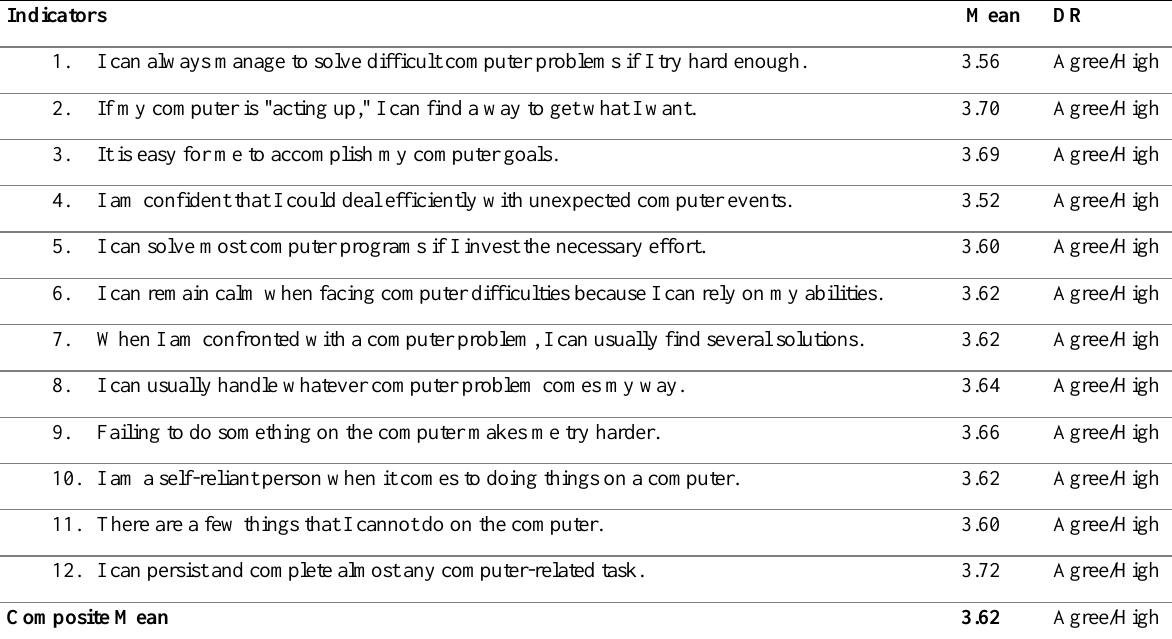
Table 1: Computer self-efficacy of the employees of Divine Word College of Laoag (n=